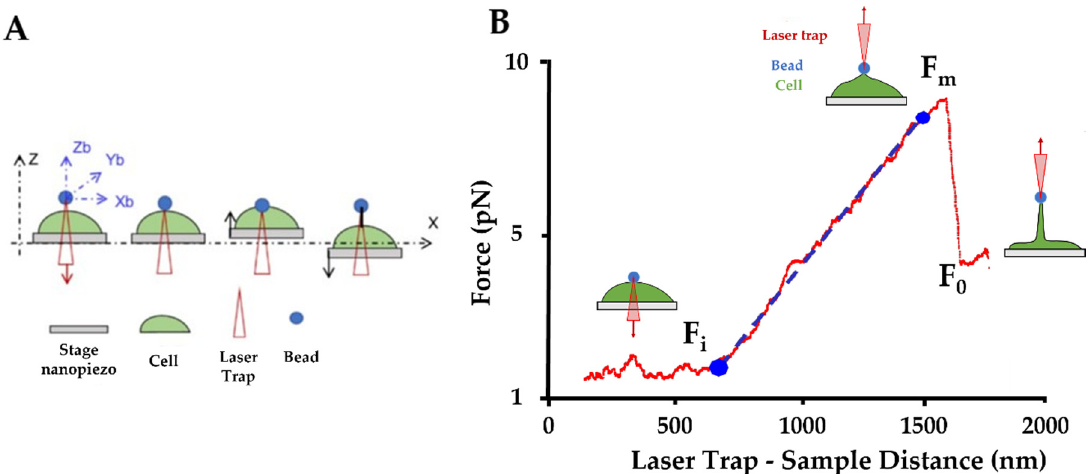
Figure 8. Optical tweezers (OT) setup. ( A ) Schematic procedure of an optically trapped bead applying a force to form a nanotube from the cell membrane. The trapped bead can be moved in three directions (Z b /Y b /X b ), in this way the bead can be put in contact with the cell. Then the trap remains in the same position, and the stage moves in Z and X direction to extract a nanotube (black line). ( B ) Force curve obtained by OT : The initial force (F i ) is the force, between bead and cell, measured during the contact step. The maximum force (F m ), is the maximum force applied to extrude the nanotube from the cell surface. The plateau force (F 0 ), is the constant force applied during the nanotube extension. The slope between the two points F i and F 0 is used to calculate the nanotube’s stiffness (blue line: slope used to stiffness; red curve: force applied on bead during the laser displacement).